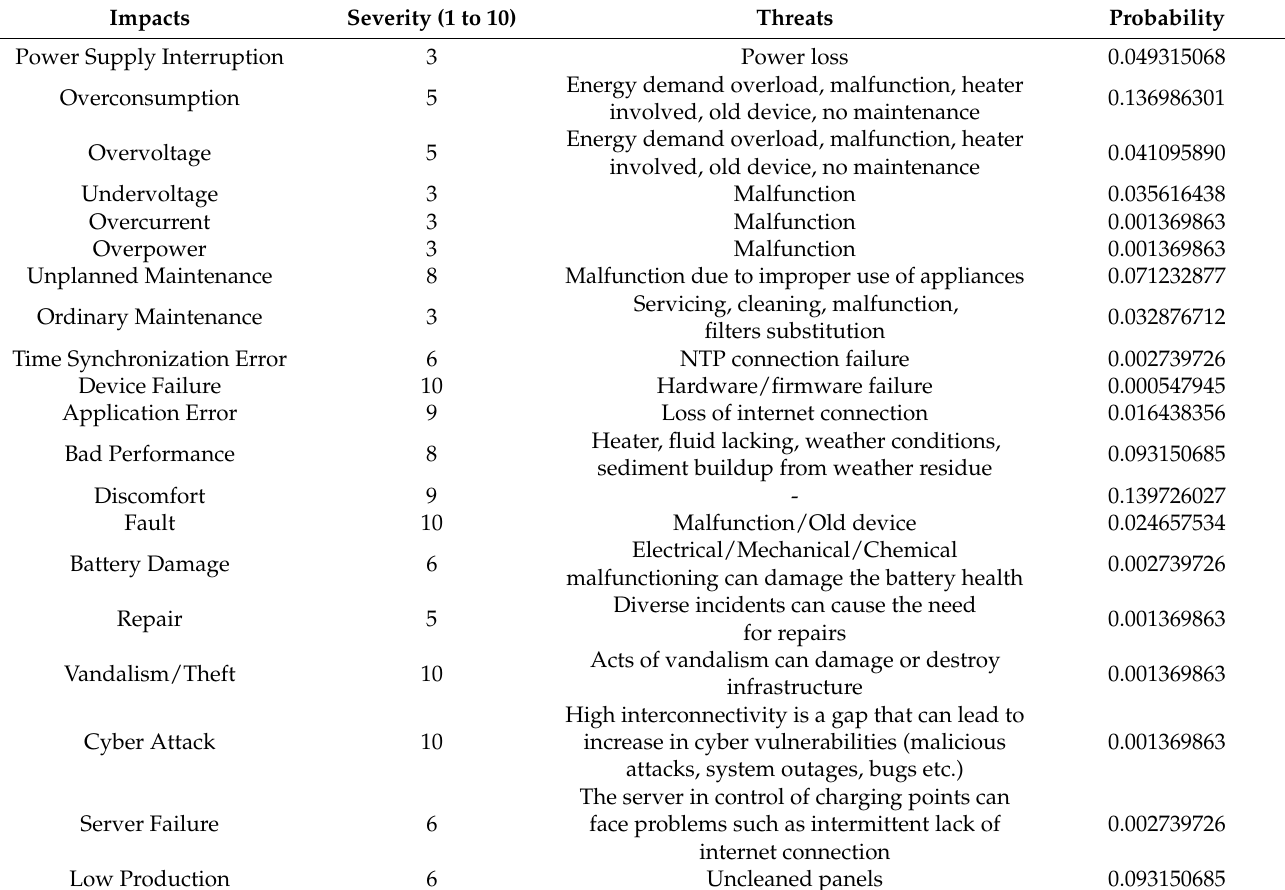
Table 1. Impact/Threat Table based on TwinERGY Partners’